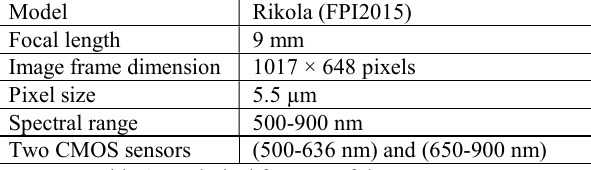
Table 1. Technical features of the FPI